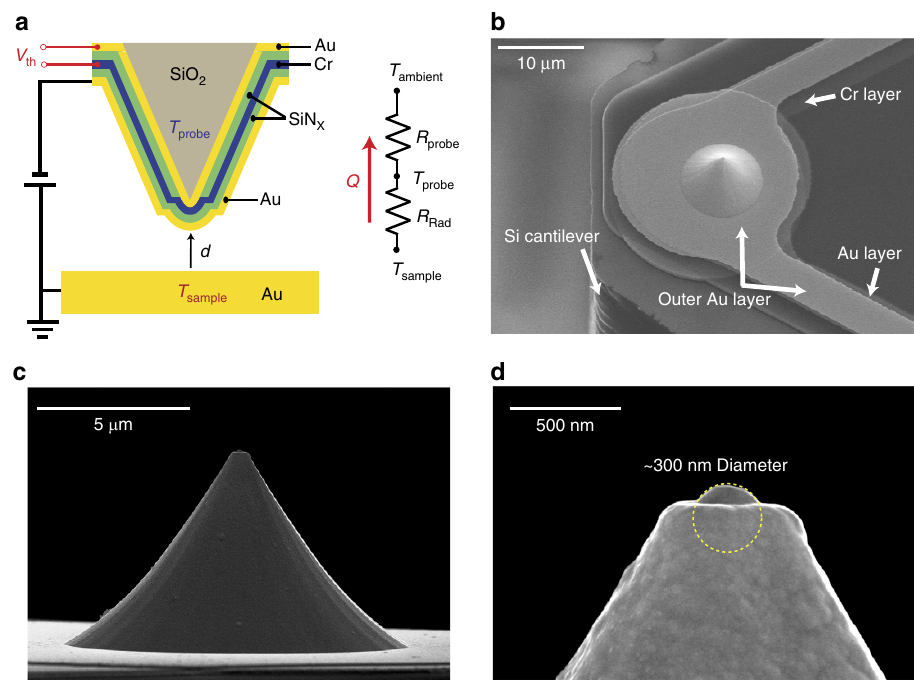
Figure 1 | Experimental set-up and SEM images of the SThM probes and gold-coated tips. ( a ) Schematic of the experimental set-up, in which a Au-coated SThM probe (cross-sectional view) is brought into close proximity of a heated Au substrate. The tunnelling current across the nanogap is monitored by applying d.c. or a.c. voltages. Simultaneously, the thermoelectric voltage ( V th ) generated by the Au–Cr thermocouple is recorded to monitor the temperature of the probe’s tip. The diagram on the right shows the thermal resistance network representing the heat flow from the substrate, through the nanogap, to the probe. ( b ) SEM image showing the top view of a SThM probe. ( c , d ) SEM images of the probe and its tip, which has a diameter of B